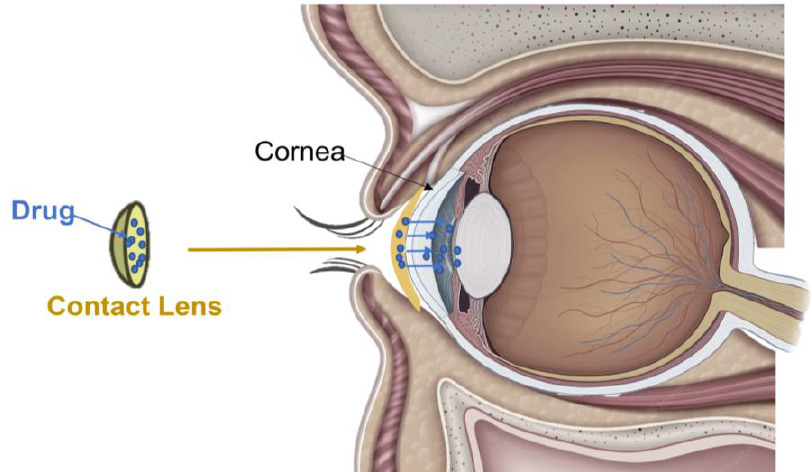
Figure 3. Representative image of a drug-loaded contact lens (CL). A drug-loaded CL is a thin and curved plastic lens characterized by a three-dimensional polymeric network of acrylate or silicone hydrogel able to capture drugs in its polymeric mesh. Once applied to the precorneal area of the eye, the CL can release the loaded drug, mainly in the anterior segment of the eye, through a diffusion mechanism.